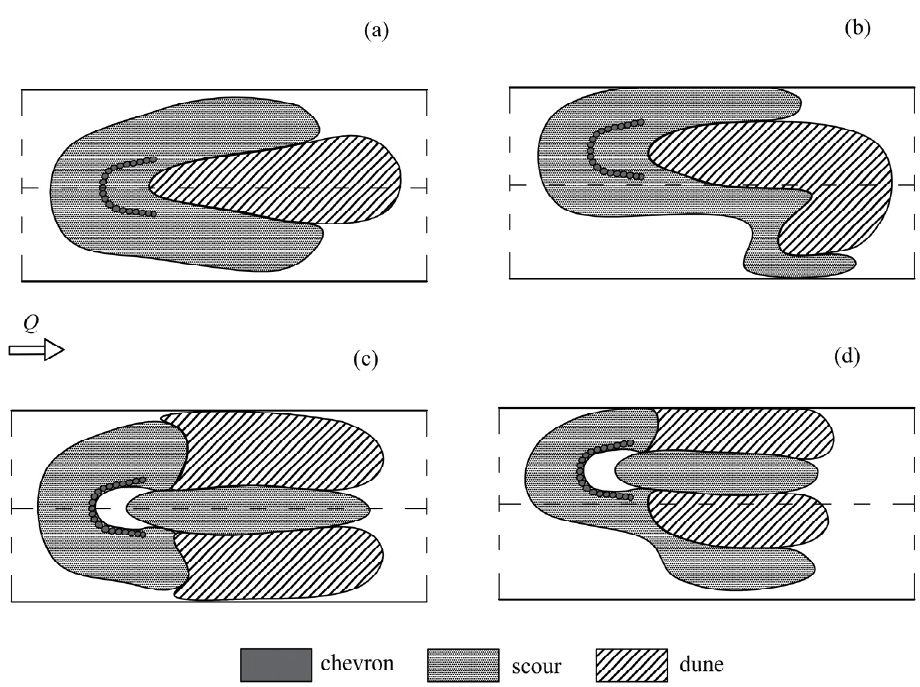
Figure 4. Scour morphology Type A for ( a ) p c / B = 0.5 and ( b ) p c / B = 0.33 and scour morphology Type B for ( c ) p c / B = 0.5 and ( d ) p c / B = 0.33 in case of single chevron structure ( n = 1) in straight channel.